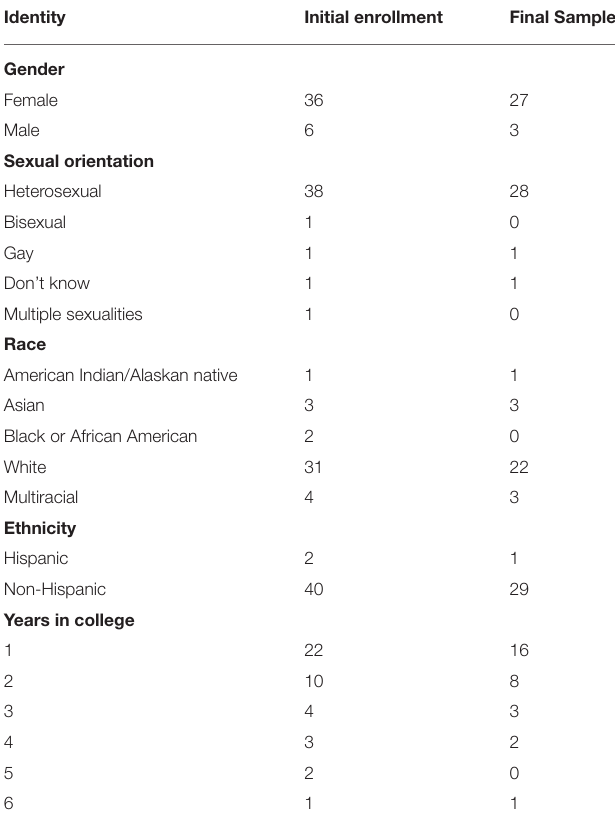
TABLE 3 | Demographics for initial enrollment compared to the final